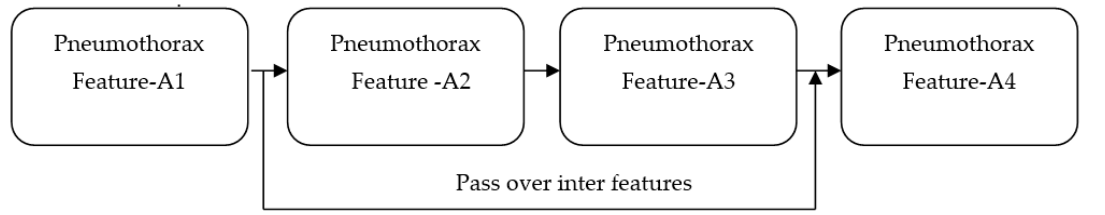
Figure 1. Addressing the vanishing gradient problem.